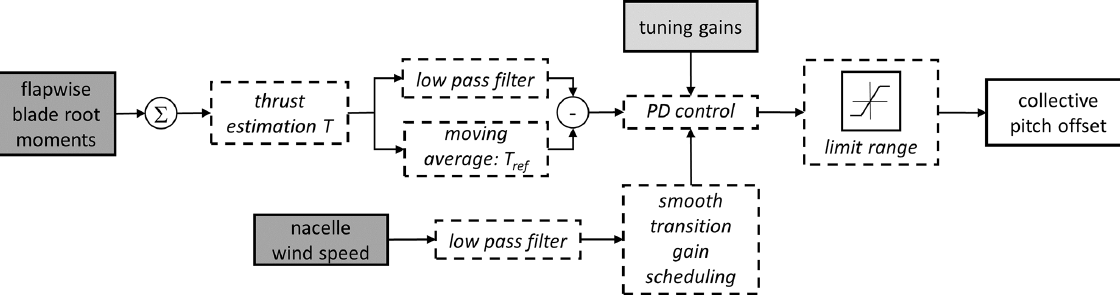
Figure 2. Flow chart of the thrust control controller